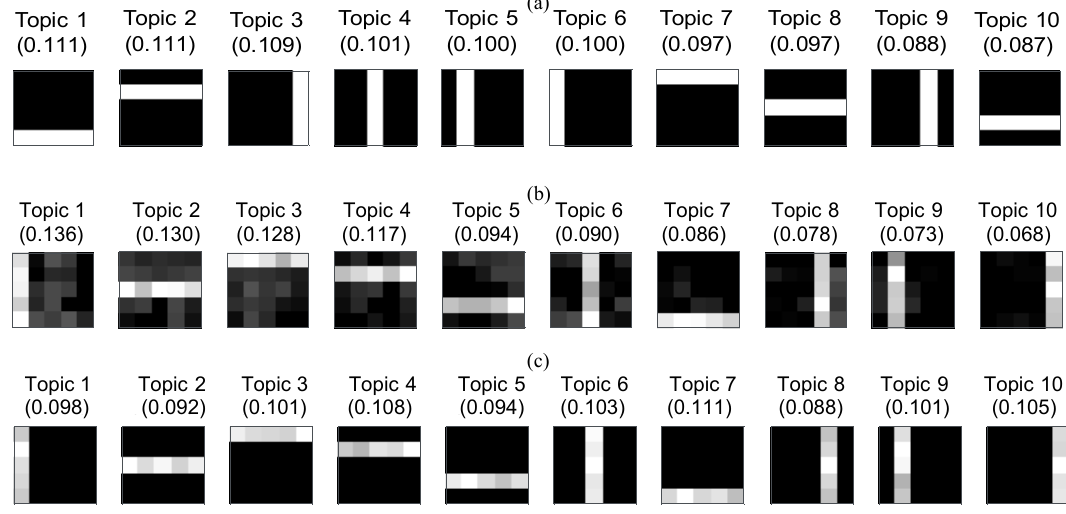
Figure 9. ( a ) Ground truth used to generate low-level data; ( b ) LDA model; ( c ) ERT model. Table 3. The 200 high-level data points for the bar numerical example. This shows many zaps in the topic definitions.